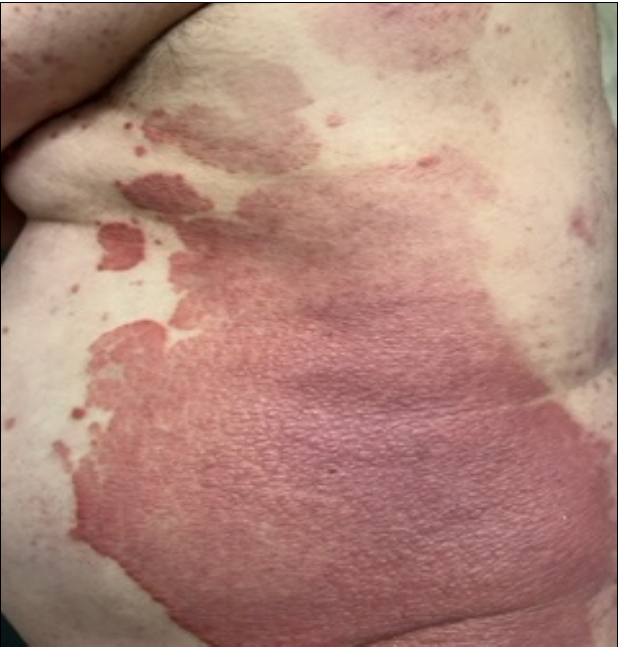
Figure 1. Clinical picture of plaque psoriasis.